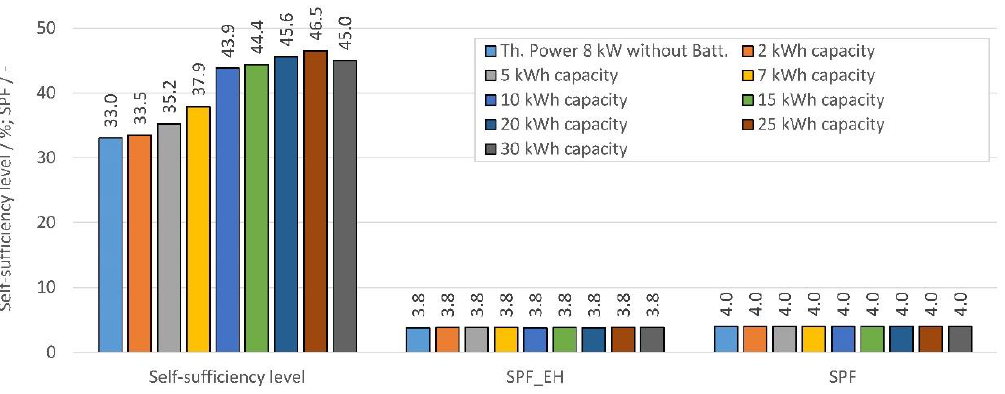
Figure 9. Self-sufficiency level (SSL) and seasonal performance factors of SFH category 4 reference buildings equipped with a BWHP for year 2020 with variation of battery size